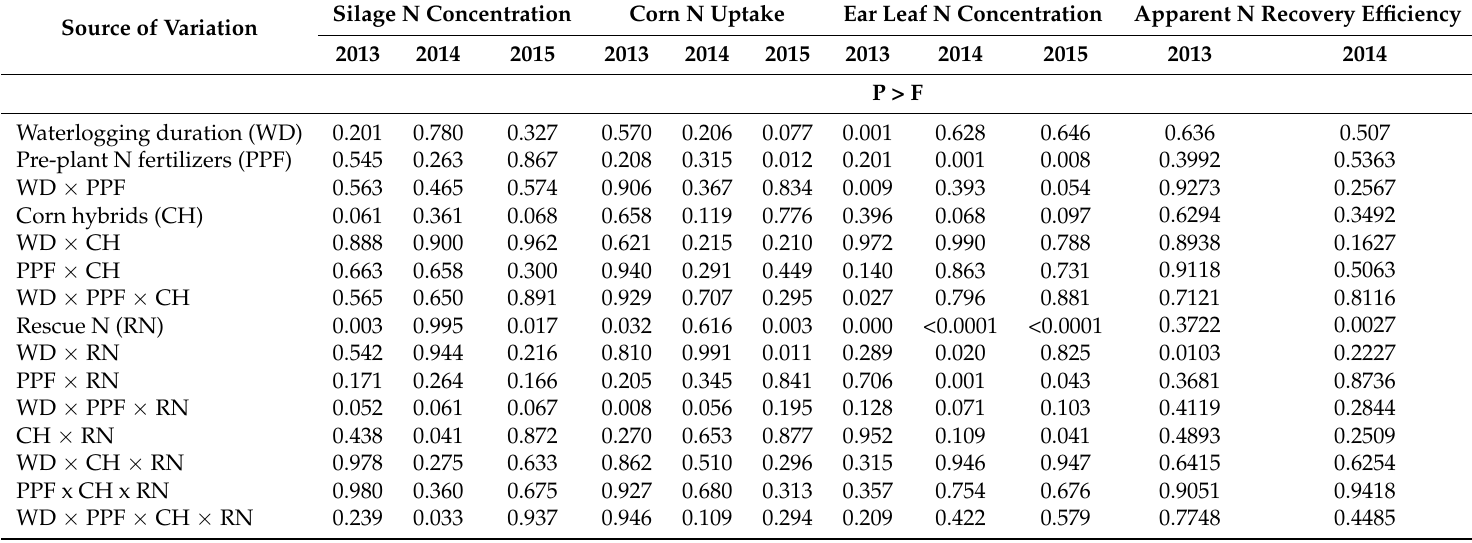
Table 3. The p -values from the MIXED procedure of SAS statistical software for corn silage N concentration, N uptake, ear leaf N concentration and apparent N recovery efficiency for the 2013, 2014 and 2015 growing